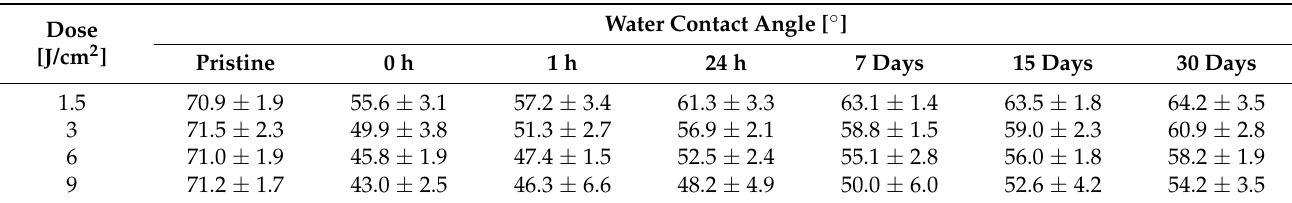
Figure 4. Water drops and contact angles on PMMA surface for different storage times: ( a ) for pris- tine: 71.31°, ( b ) right after UV exposure of 6 J/cm 2 : 45.39°, ( c ) 24 h after UV exposure of 6 J/cm 2 : 51.89°, ( d ) 30 days after UV exposure of 6 J/cm 2 : 59.36°. Table 1. Water contact angle of PMMA for non-rinsing samples after UV exposure.